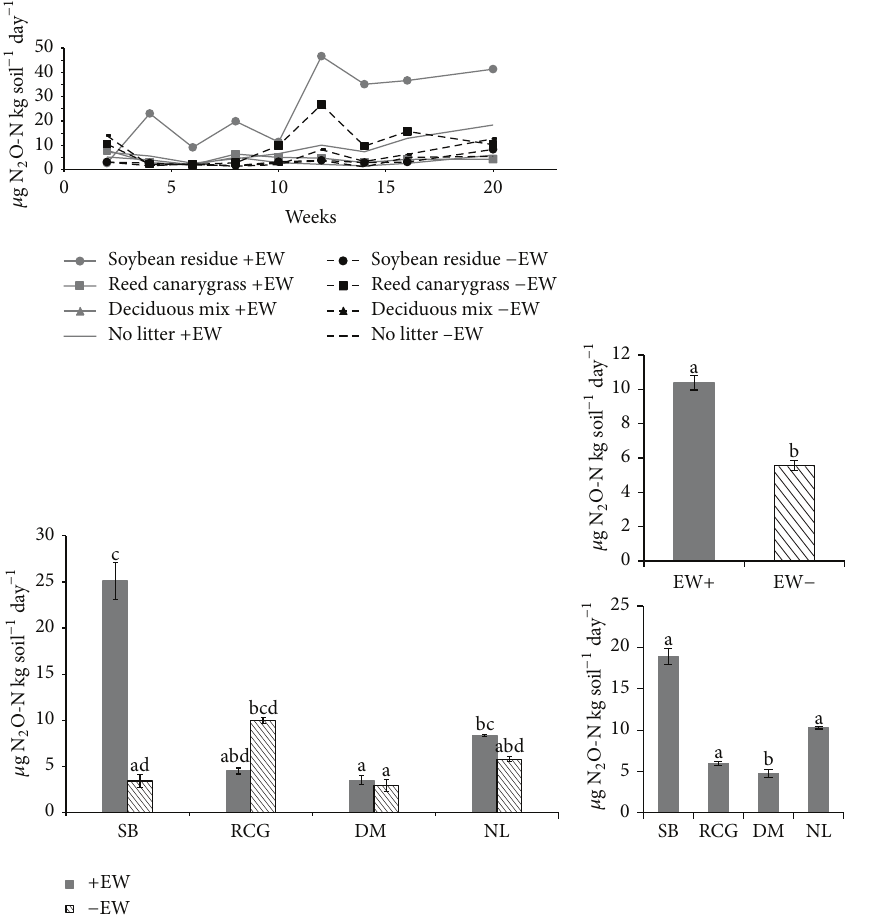
Figure 2: Mean N 2 O fluxes over time from each treatment combination (litter × earthworm) from microcosms with riparian soil over 20 wks. Bar graphs indicate mean N 2 O fluxes averaged from nine sampling dates, according to litter × earthworm treatments ( 𝑛 = 36 ), earthworms ( 𝑛 = 144 ), and litter effects ( 𝑛 = 60 ). Litter treatments are labeled according to no litter (NL), soybean (SB), reed canarygrass (RCG), or deciduous-mix litter (DM). Error bars represent the standard error of the mean. Lower-case letters (a, b, c, and d) represent differences due to the litter × earthworm interaction ( 𝑃 < 0.05 , Kruskal-Wallis